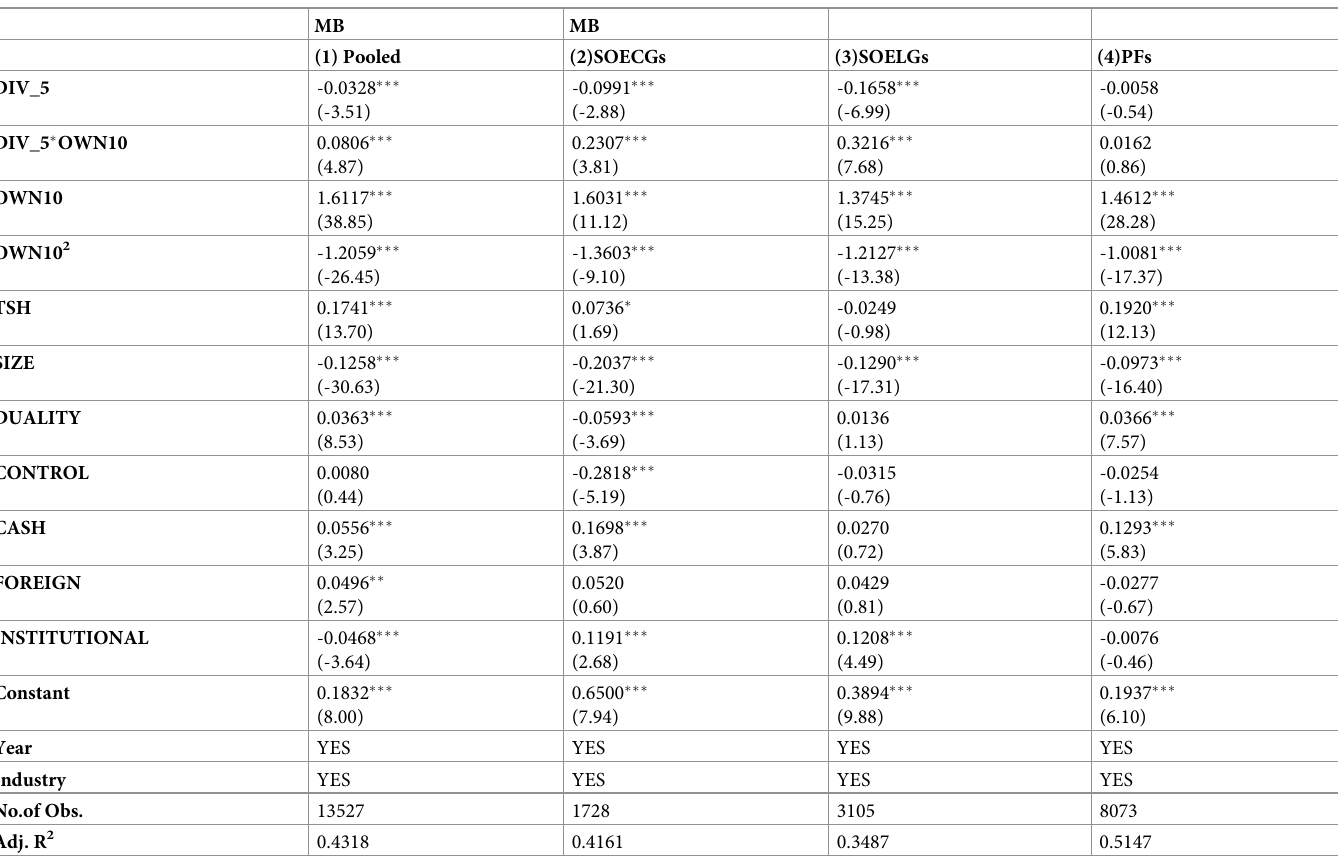
Table 8. Robustness test: OWN10 as an alternative measure of ownership